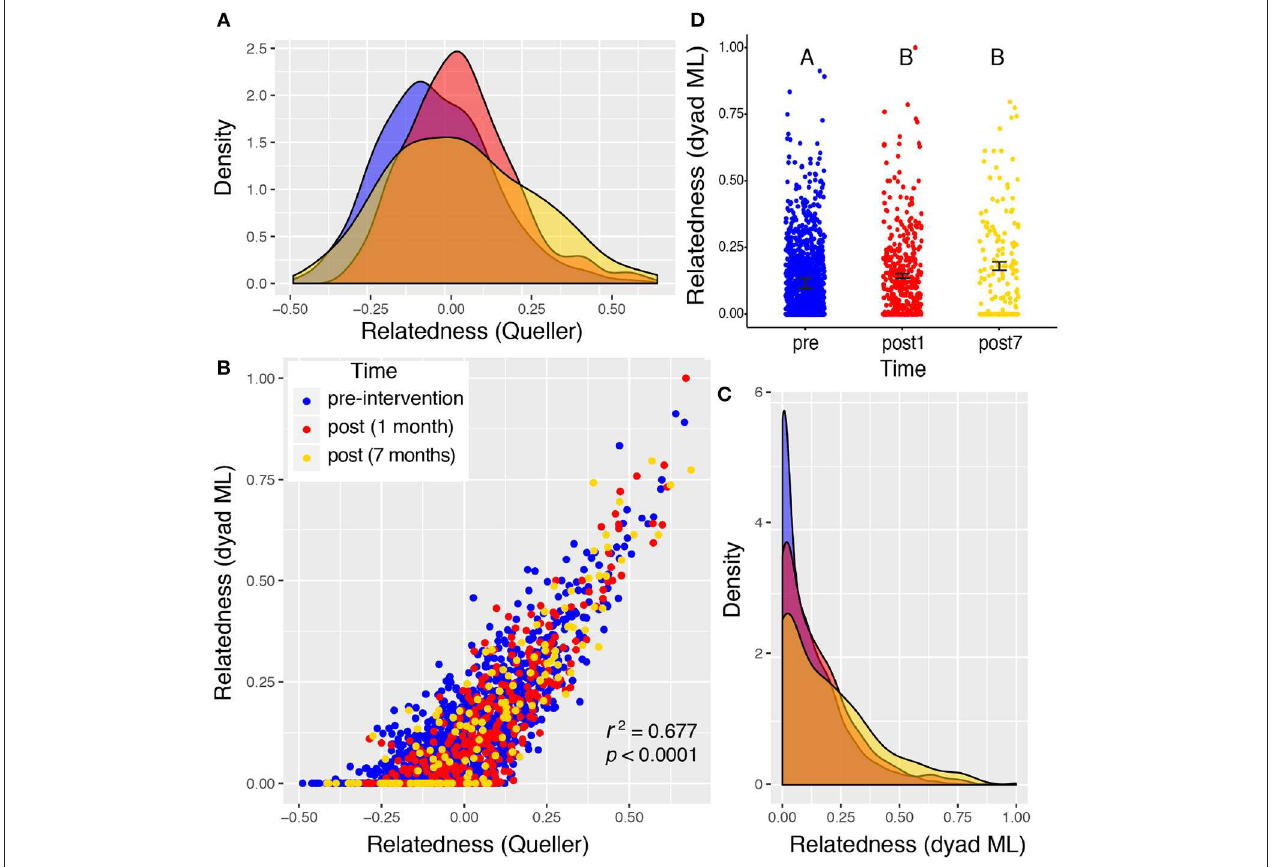
FIGURE 6 | Valley 4: two very different measures of relatedness suggest that there is a significant change in the distribution of relatedness between individual rats sampled pre- and post-eradication in Valley 4, represented by density distributions below (A,C) . The Queller-Goodnight relatedness coefficient can take negative values (a), while the Milligan dyad maximum likelihood (dyad ML) metric is bounded by zero and one (C) . The two metrics are tightly correlated in this data set (B) . A Kruskal–Wallis test was used to determine if the distribution of relatedness values differed among the three time points sampled around the 2015 eradication campaign (D) . The upper-case letters above the points in panel (D) indicate that there is a significant difference between the distributions of relatedness from the pre- and post-eradication periods, but the two post-eradication periods are not significantly different from each other. Black bars represent the mean ±